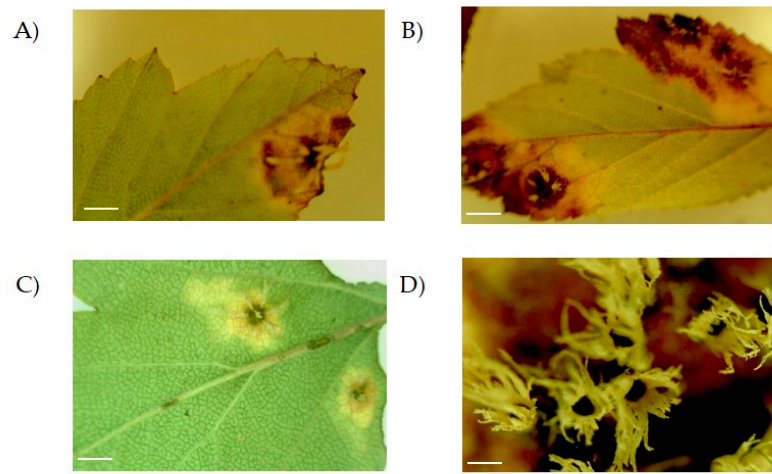
Figure 1. Lesions observed on leaves of Crataegus sp. plants. Samples were observed using the microscope with the 10X objective. The lesion evolved as a yellow and brown spot on the surface covering different parts of the leaf (compare ( A ), ( B ) and ( C ); scale bar = 0.5 cm). An enlarged view of the structures can be observed in ( D ) with the 40X objective; scale bar = 0.5 mm.